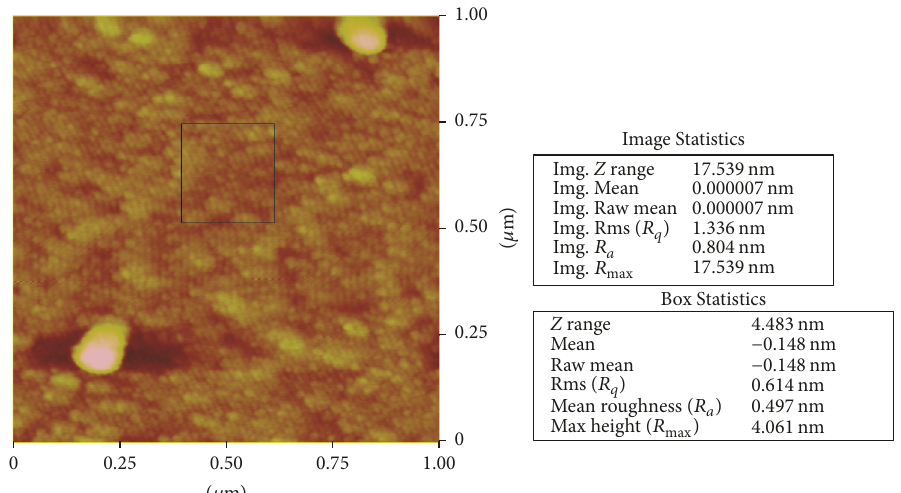
Figure 5: Roughness analysis of the sample irradiated for one hour at 254 nm.